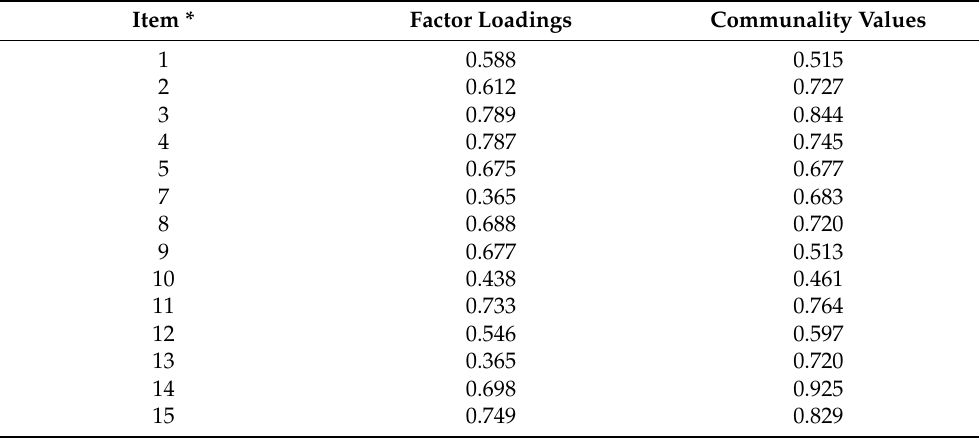
Table 3. Exploratory factor analysis of the 14-itema Infection Prevention Appraisal